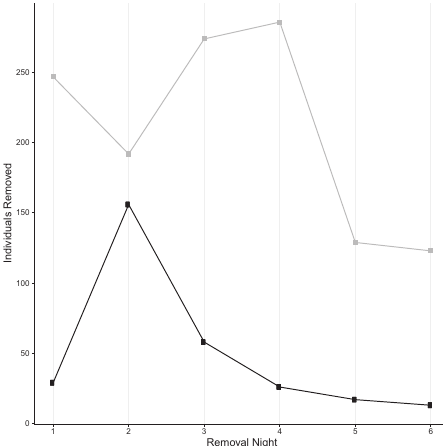
Figure 1. Numbers of individual cane toads captured per night on Horan (gray) and Indian (black) Islands.